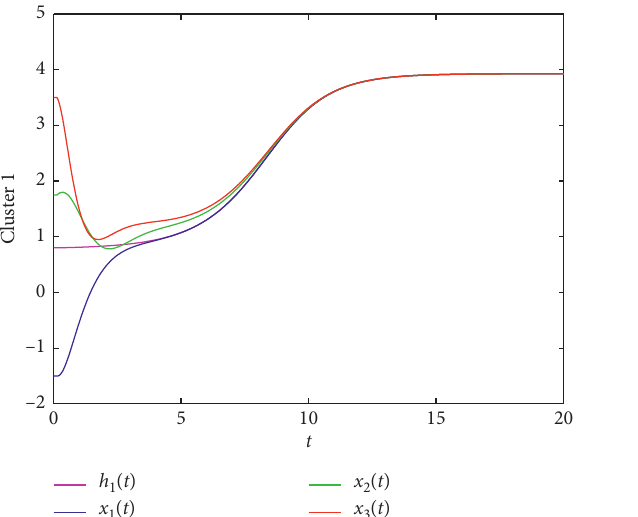
Figure 2: State trajectories of cluster 1.